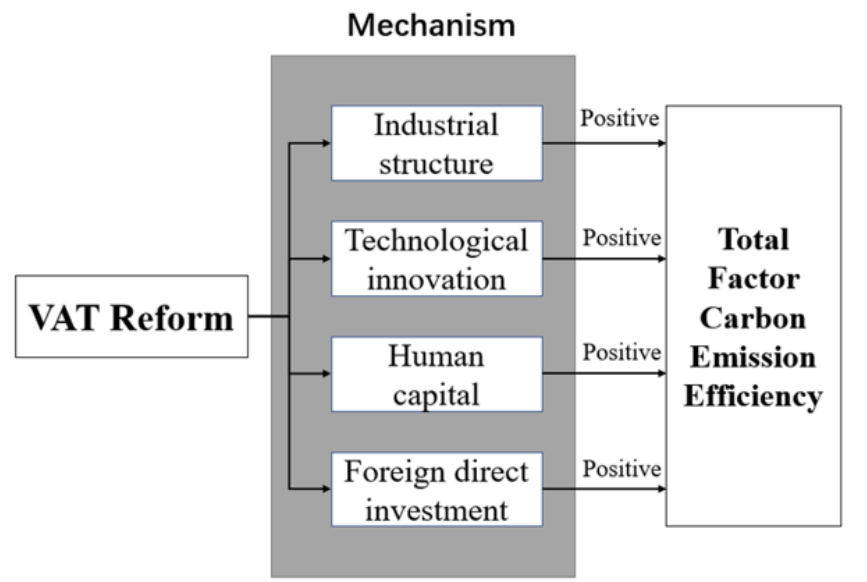
Figure 1. The impact of VAT reform on TFCEE. Source: drawn by the author. As shown above in the mechanism analysis, the impact of VAT reform on TFCEE is mainly through four aspects: industrial structure, technological innovation, FDI, and human capital, and we expect the impact of VAT reform on TFCEE to be positive.